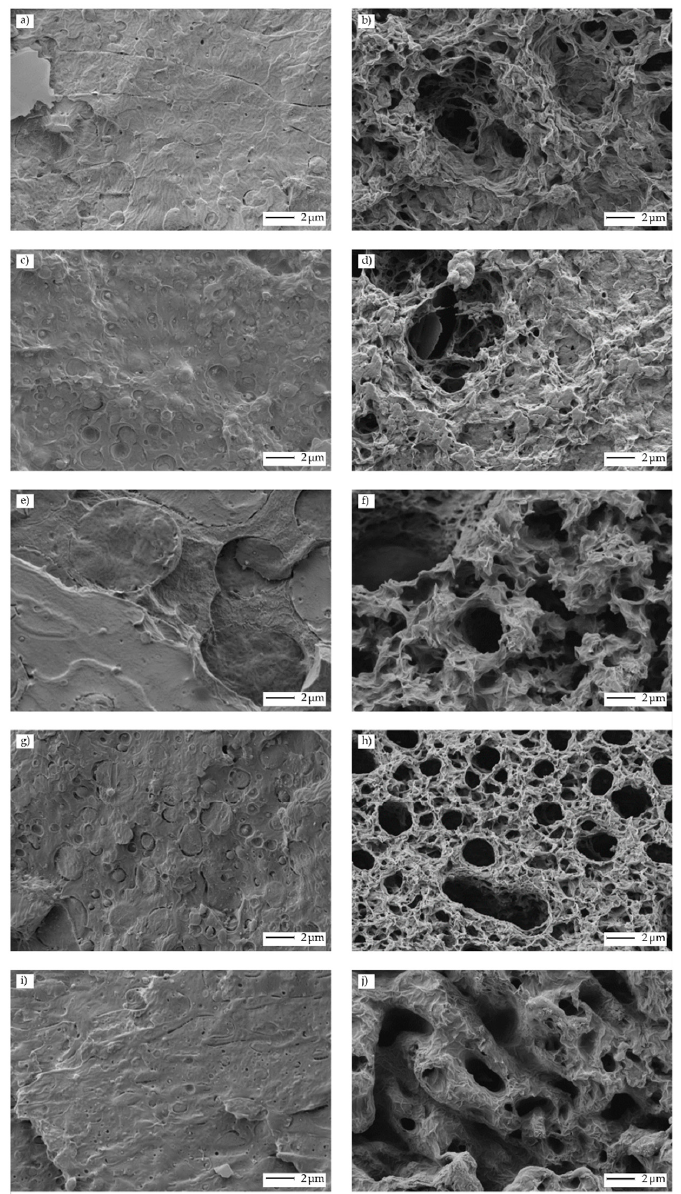
Figure 4. Field emission scanning electron microscopy (FESEM) images of cryofractured samples without chemical attack ( left column ) and with chemical attack ( right column ) at 5000 × corresponding to PLA/PHB/PCL ternary blends (wt % PLA/wt % PHB/wt % PCL) ( a , b ) (100/0/0); ( c , d ) (60/40/0); ( e , f ) (60/30/10); ( g , h ) (60/20/20); ( i , j ) (60/10/30); and ( k , l ) (60/0/40). The scale bar represents 2 µm.